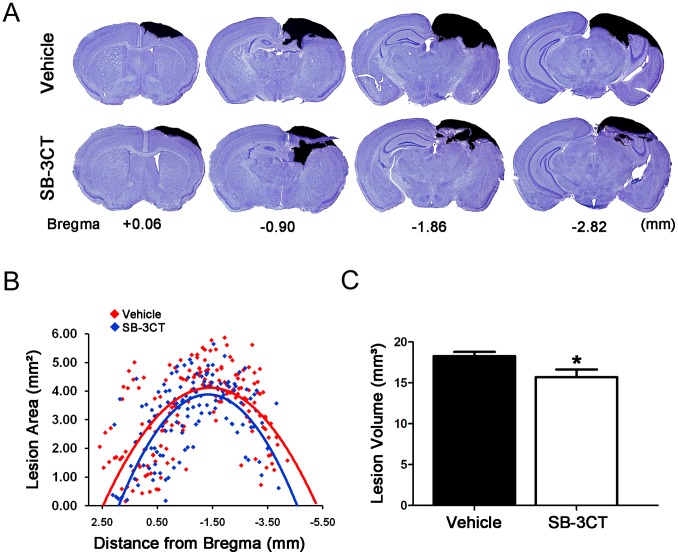
Histopathological quantification of lesion volumes in cresyl violet-stained brain sections at 7 days post-trauma.
A. Representative cresyl violet-stained coronal brain sections from vehicle and SB-3CT-treated mice marked with their coordinates to Bregma. The black area in each section shows the contralateral hemisphere superimposed on top of the lesioned hemisphere to visualize the brain damage regions. B. Stereological scatter-plot of lesion areas in the cresyl-violet stained sections of vehicle and SB-3CT-treated mice at 7 days post-trauma. Each data point represents the lesion area in one cresyl violet-stained brain section, and plotted according to the rostro-caudal axis of the brain coordinate to Bregma. A second degree polynomial was generated to fit data points to visualize data trends. The graphs indicate a difference in lesion area between vehicle and SB-3CT-treated mice. C. Quantification of cortical lesion volume at 7 days post-trauma in the SB-3CT-treated mice compared to the vehicle-treated mice. n = 6 in each group; *, p<0.05 by one-tailed, unpaired Student’s t-test. Data expressed as mean ± SEM.